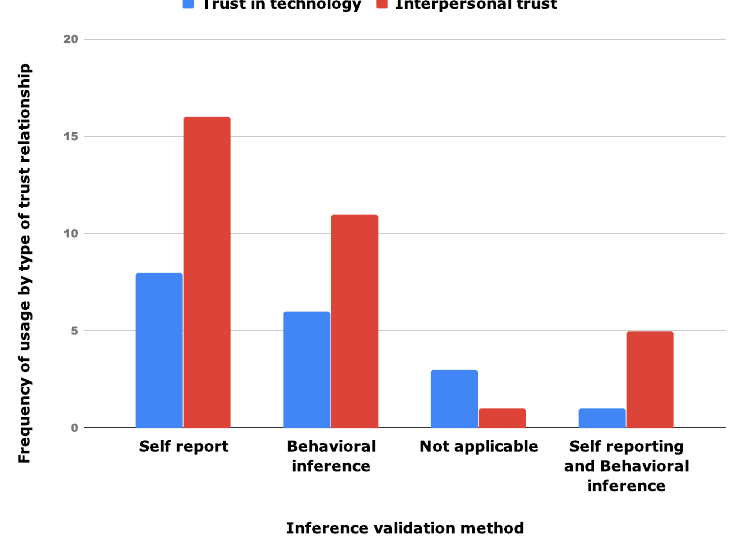
Figure 8. Inference validation methods and usage frequency in studies assessing trust with psychological signals across contexts.